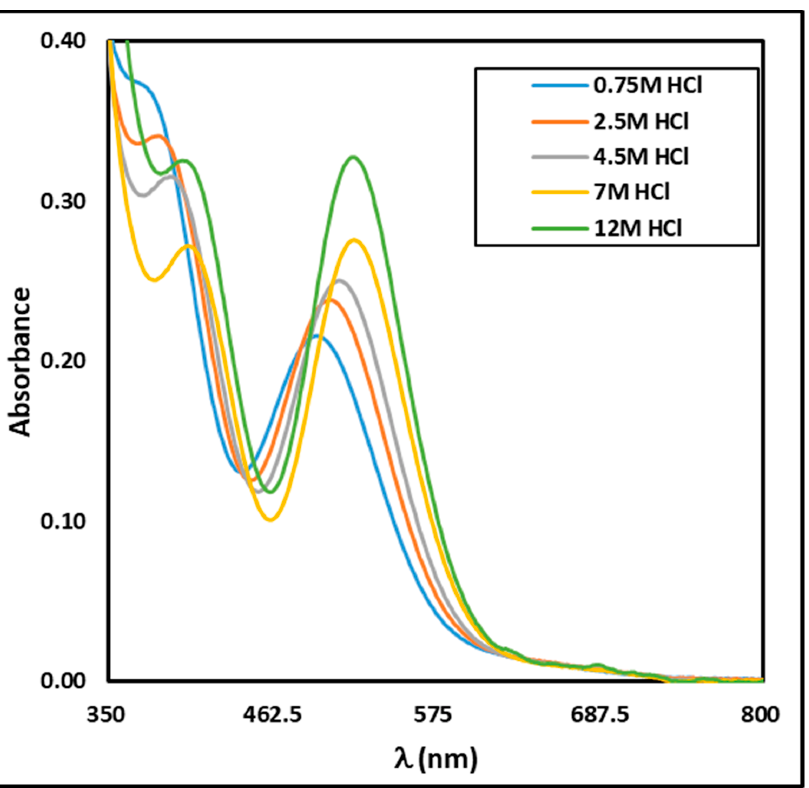
Figure 2. Some experimental UV-vis spectra of the Rh aqueous solutions (2.4 × 10 − 3 M)—influence of HCl concentration.